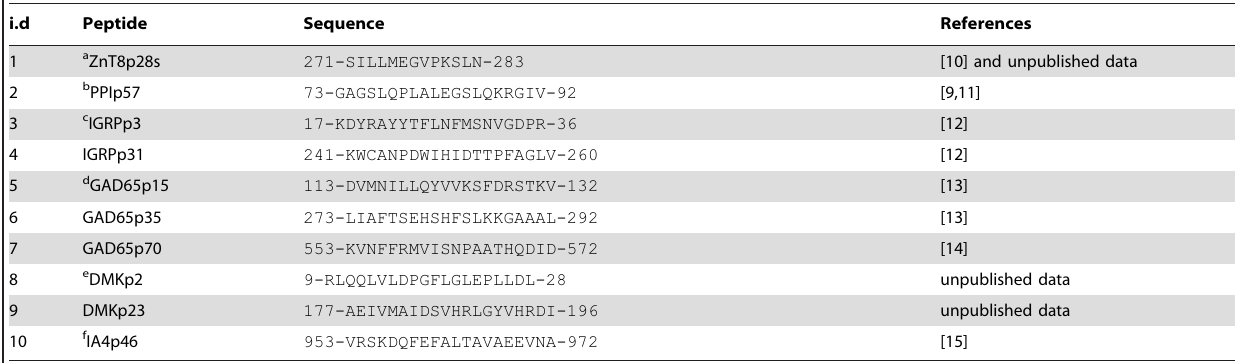
Table 2. Putative beta-cell autoantigenic peptides.